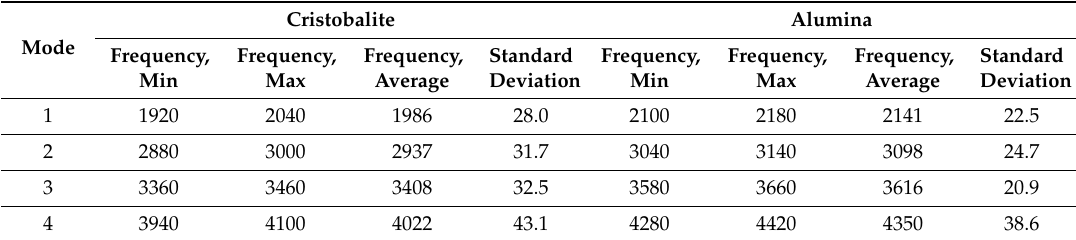
Table 3. Range of natural frequency according to